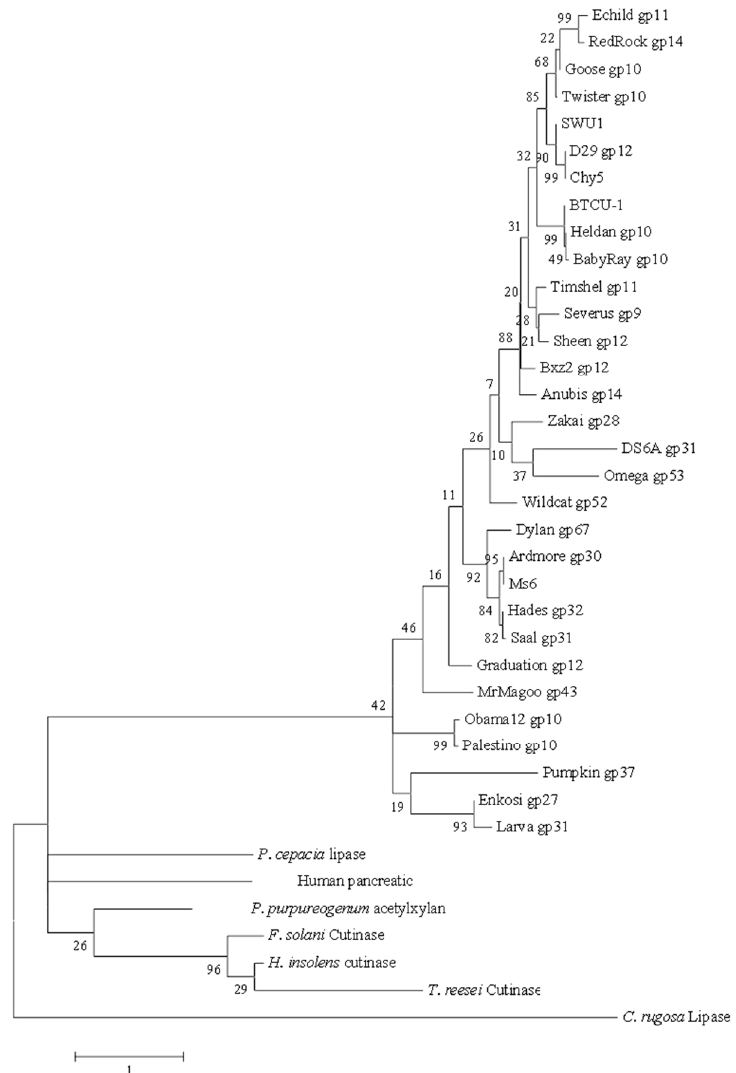
Figure 2. Phylogenetic tree for LysB proteins of mycobacteriophage D29 and its 30 homologs, and relative members of the α / β hydrolase family. The tree was built using maximum likelihood (ML) method by MEGA 6.0. The bootstrap values are shown at every node. The high bootstrap value at each node reveals the significance of its branching.